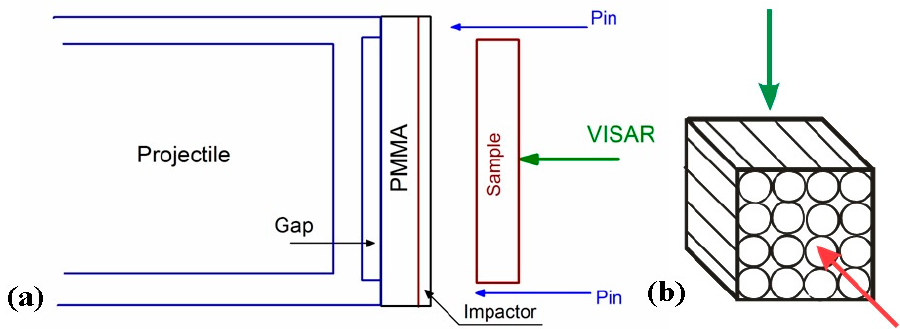
Figure 2. The scheme of experiments ( a ) and the direction of load relative to sample texture ( b ). Red arrow means load direction along the deposition direction, green means across.